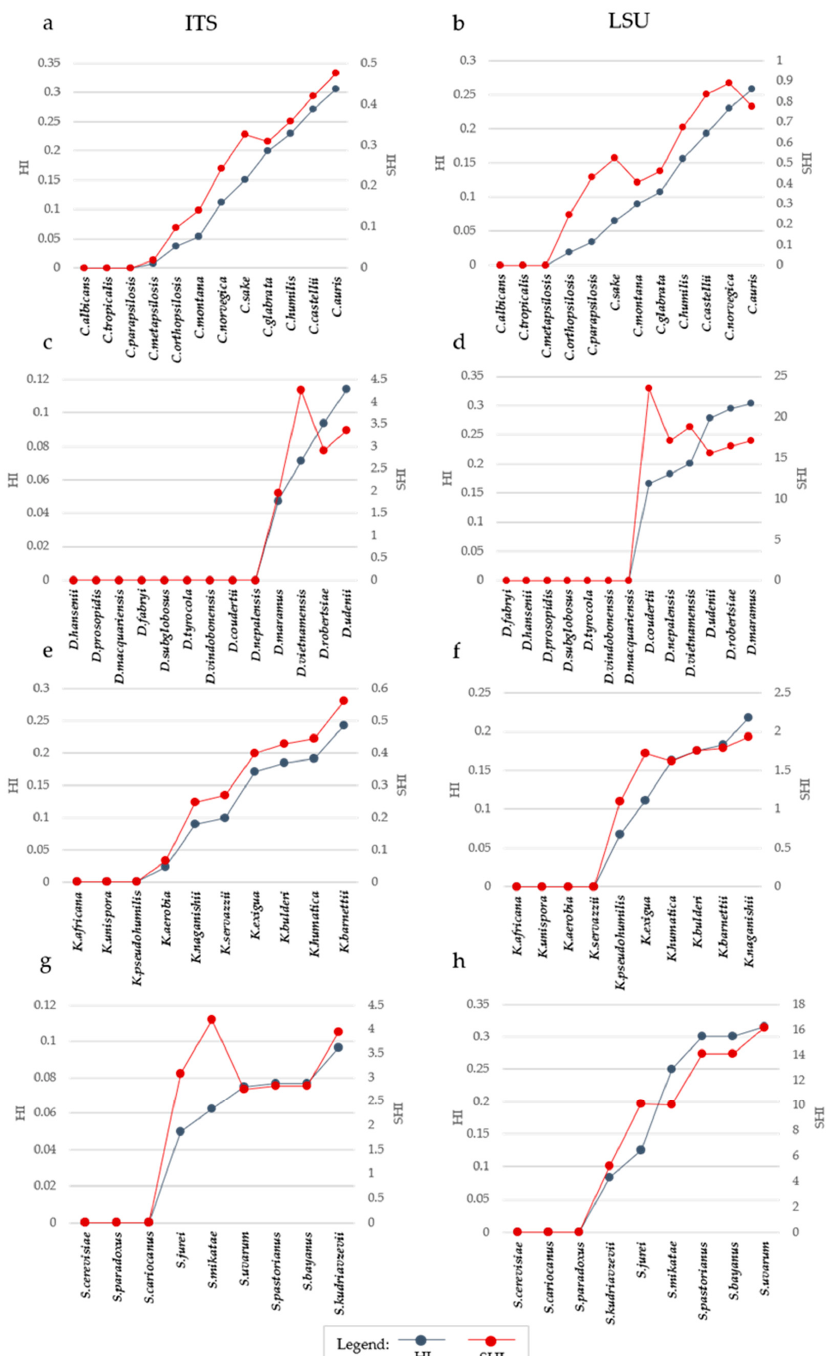
Figure 3. Trend of Homoplasy Index (HI) and Specific Homoplasy Index (SHI) with the increase of distance and number of species. Each plot reported in the primary Y-Axis (on the left) the value of HI, while the secondary Y-Axis (on the right) reported the value of SHI. In the X-Axis species are reported. Species are displayed in increasing distance order from the center, represented by the leftmost species of each graph. The plot shows the increase of homoplasy index (blue line) influenced by both the addition of strains to the series and the increase of distances. The red line shows the trend of the SHI. It is calculated as the ratio between HI and MaxD, which is the maximum distance of the alignment. ( a , b ) show the trend for Candida ITS and LSU , respectively. While panels ( c , d ) represent the trend for Debaryomyces ITS and LSU , respectively. ( e , f ) shows the trend for Kazachstania ITS and LSU , respectively. While ( g , h ) represent the trend for Saccharomyces ITS and LSU , respectively. SHI index results from the ration of HI and the corresponding distances, and therefore is a sort of Homoplasy normalized by the